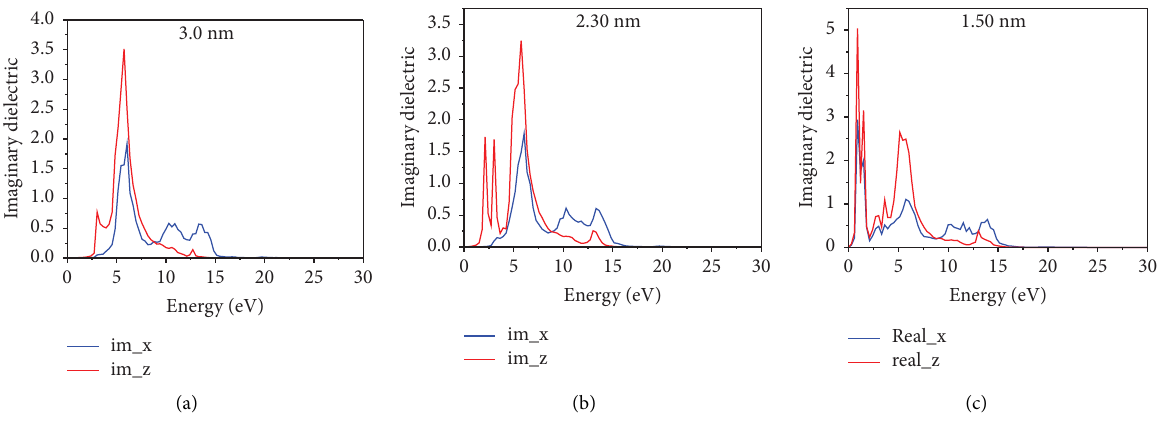
Figure 9: Imaginary dielectric functions for armchair CBNNT under diferent